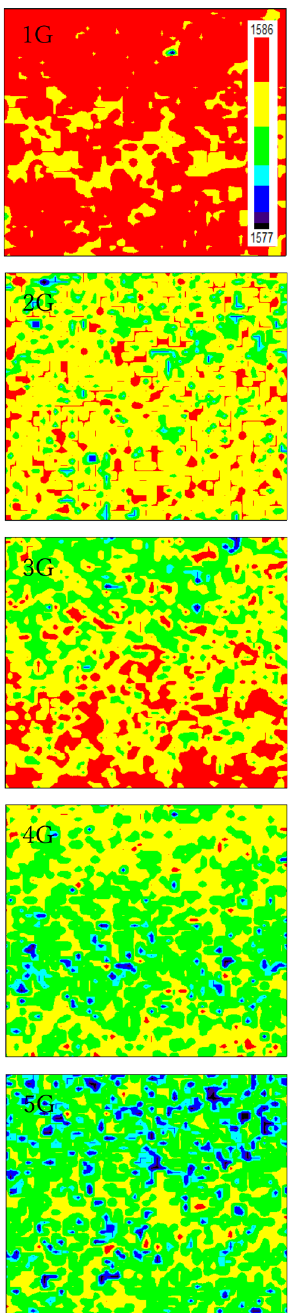
Figure 4. Wavenumber mapping of the G band for mono-, bi-, tri-, tetra-, and penta-layer graphene/LiNbO 3 − 1 − 1 structures between 1577.0 cm and 1586.0 cm